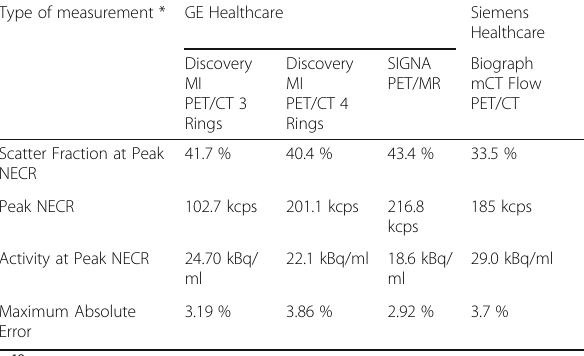
Table 2 (abstract A29). Counting Rate